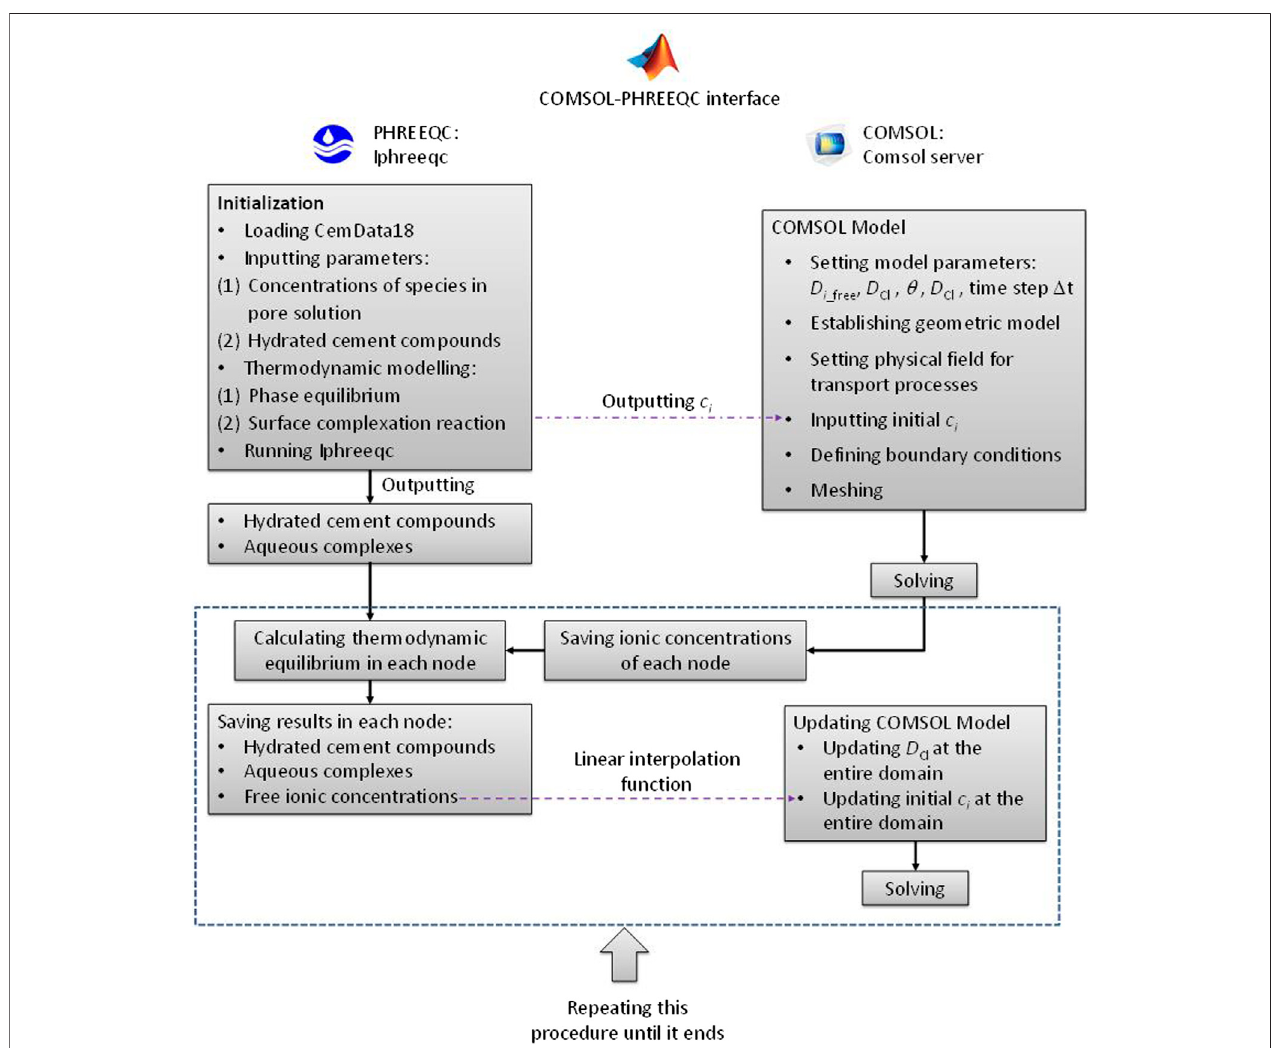
FIGURE 1 | Main structure and work fl ow of the COMSOL-PHREEQC interface to calculate the reactive transport model.